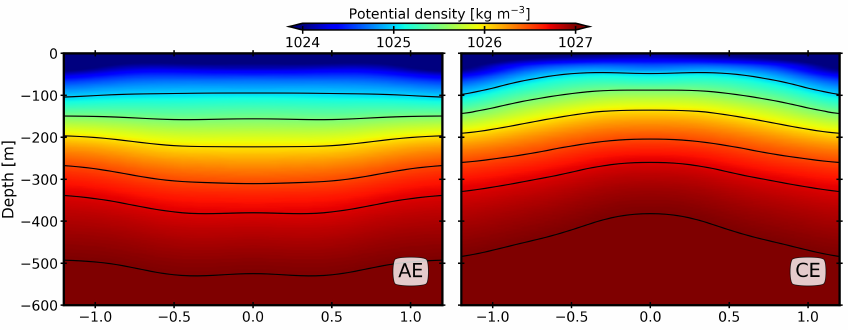
Figure 8. The 3D structure of the potential densities of AC and CE (as a function of the depth). The CE potential density curves obtained above 500 m depth are concave and symmetrical for radii between − 1 and 1 and the potential density curves obtained are slightly straight above 200 m in depth while for depths between 200 and 500 m they are convex.